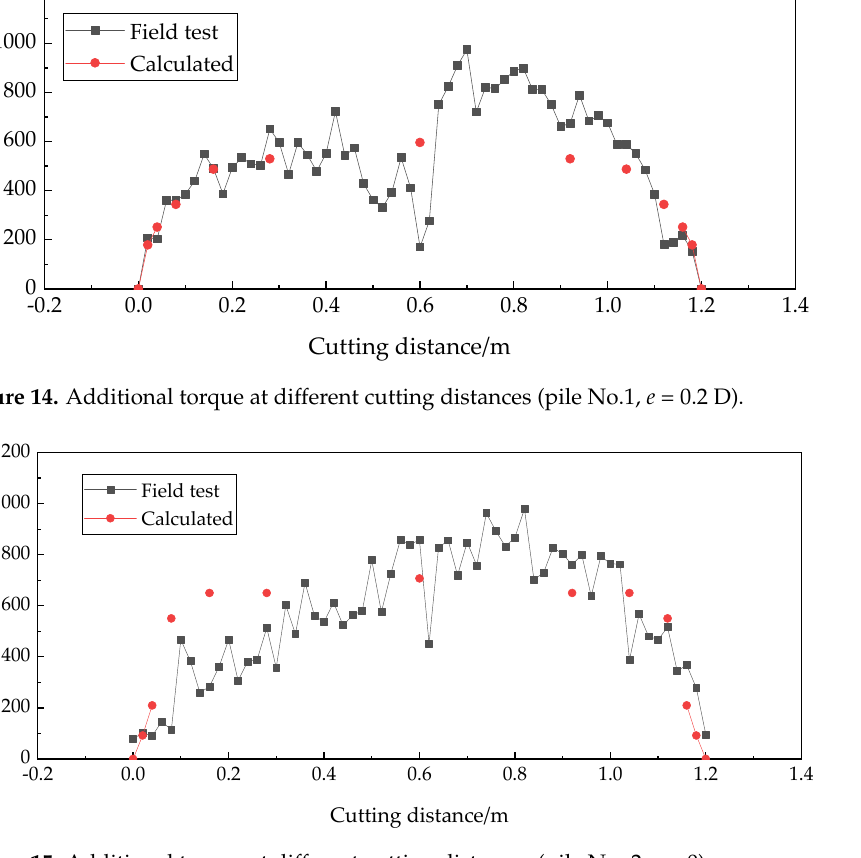
Figure 15. Additional torque at different cutting distances (pile No. 2, e = 0).